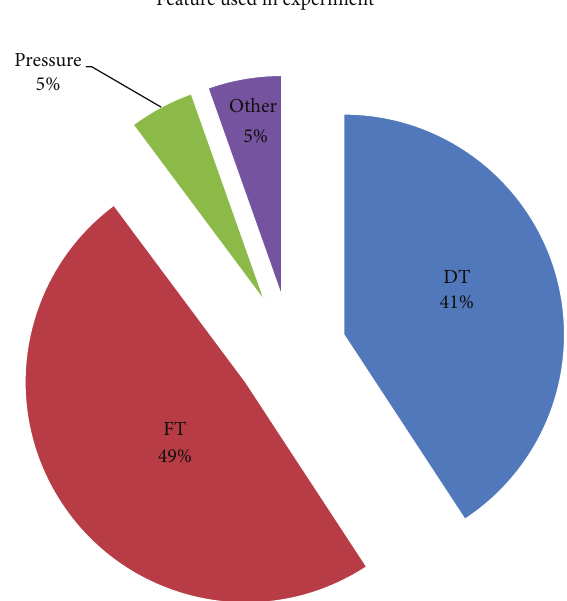
Figure 6: The percentage distribution of feature data extracted for keystroke experiment in the